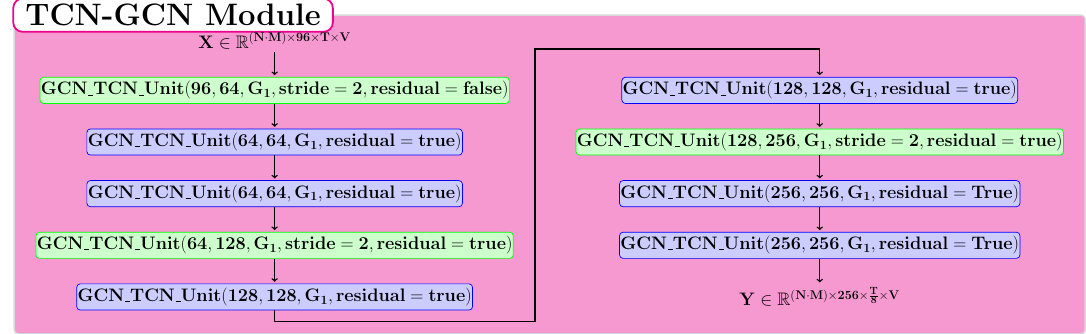
Figure 5. The proposed structure for the TCN-GCN module.